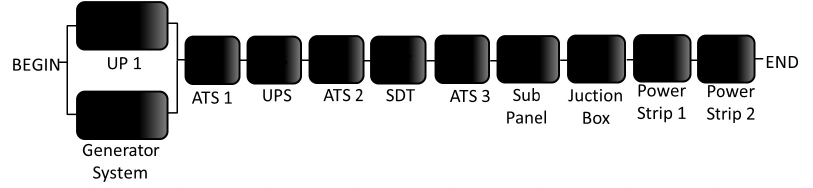
Figure 12. RBD model of the Tier I power infrastructure.